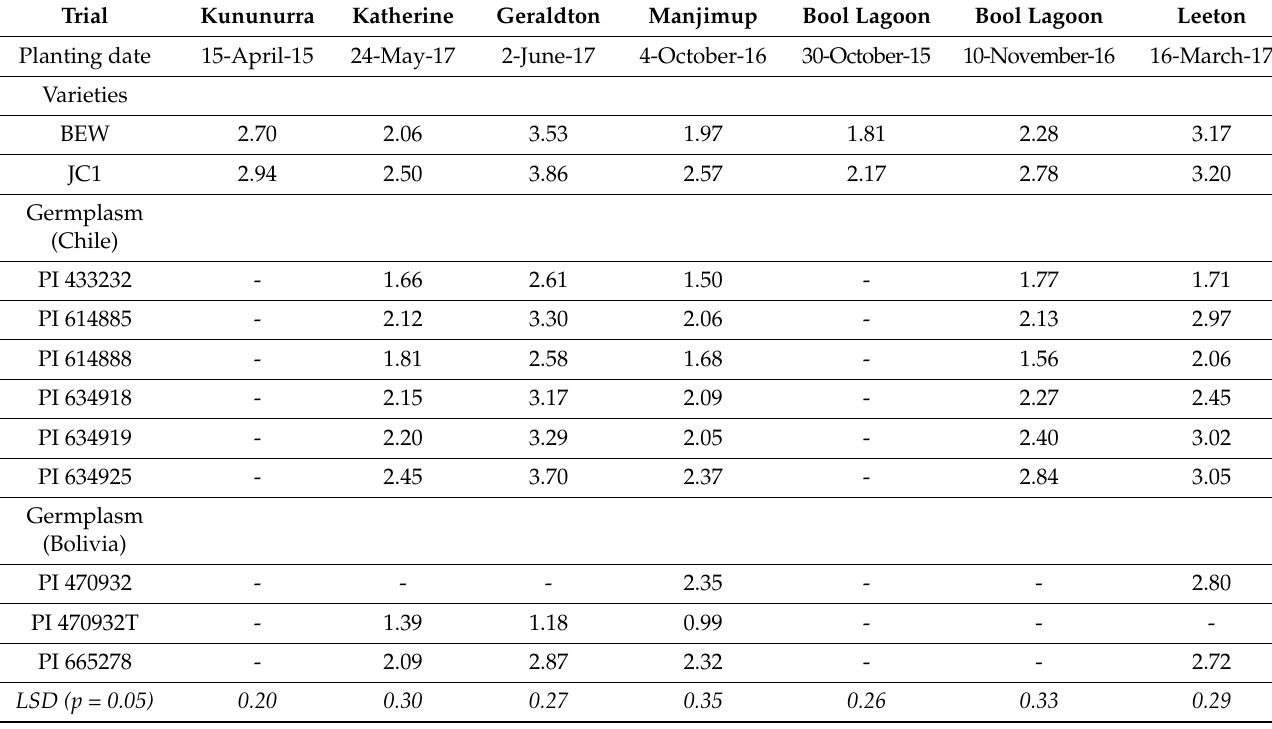
Table 12. Seed weight at selected field trials